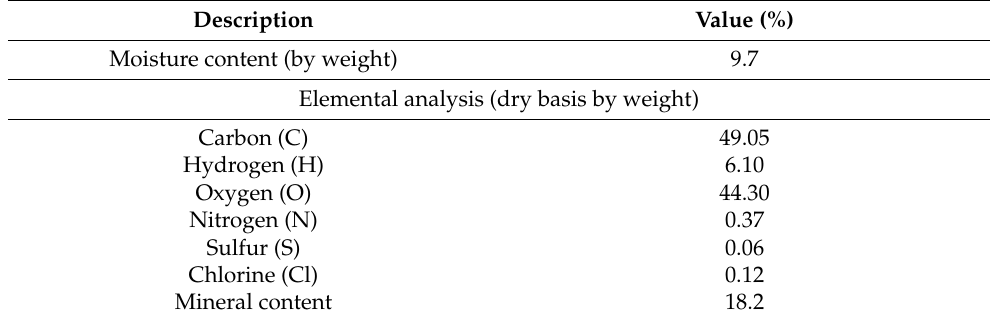
Table 4. Composition of Rice husk biomass [45].